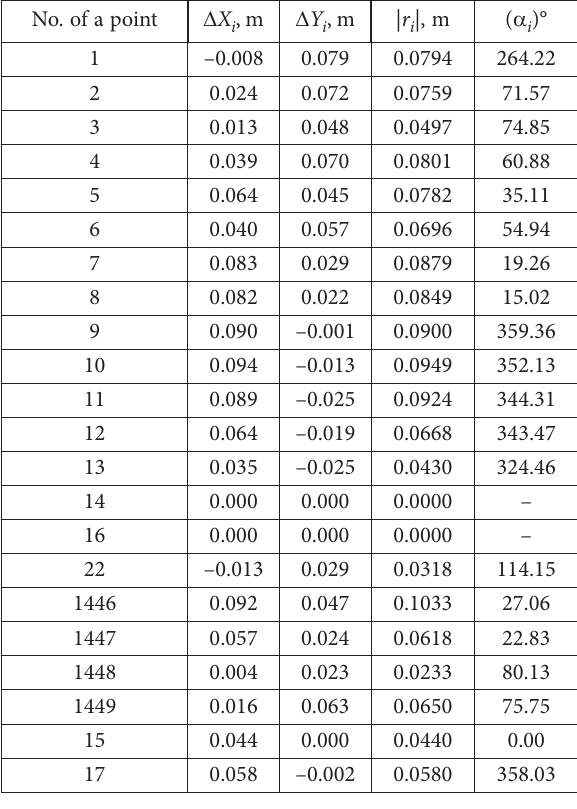
Table 2. Results of calculation of modules and directional angles of error